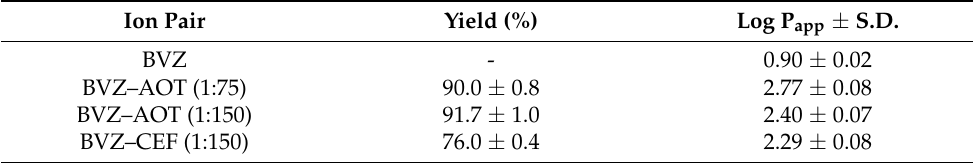
Table 2. Yield of ion-pair formation and log P app ± SD of ion